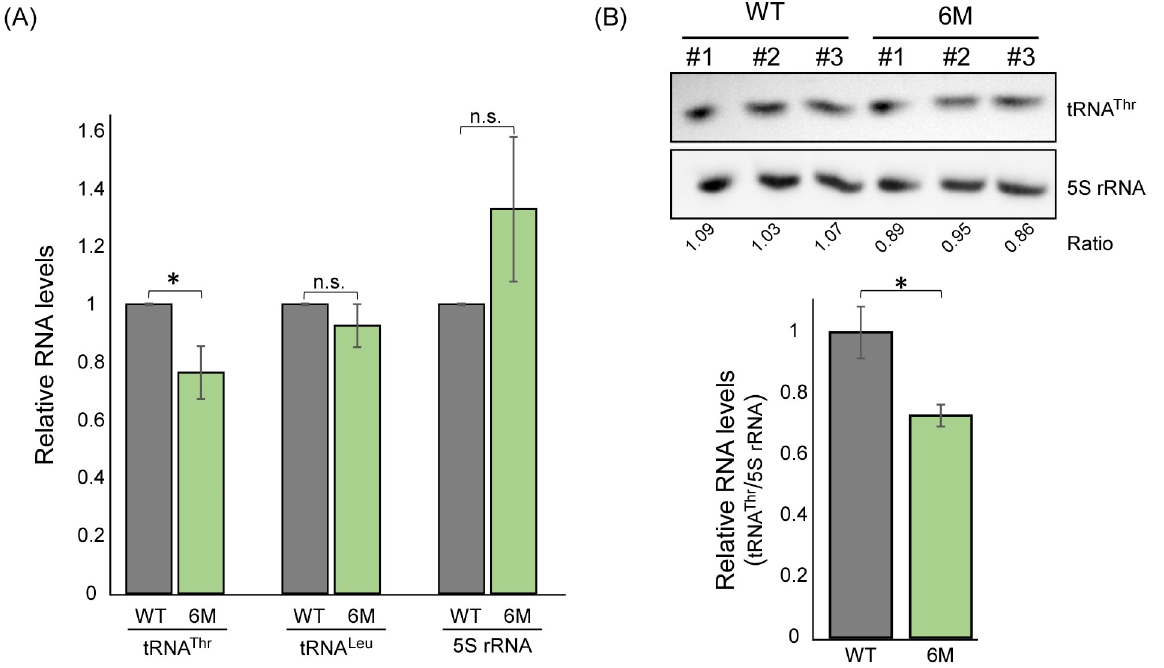
Figure 5. RPC10 impact on tRNA Thr expression. ( A ) Amounts of tRNA Thr(AGU) , tRNA Leu(CAA), and 5S rRNA were quantified in the indicated strains by RT-qPCR analysis and normalized to ACT1 expression levels. The histogram presents the quantification of five independent biological repeats. ( B ) RNA samples (2.5 µ g) from the indicated strains (three biological replicates each) were resolved on 10% acrylamide/8 M Urea gel and subjected to northern analysis with Biotin-labeled probes followed by detection with HRP-conjugated streptavidin and an ECL reaction. ’Ratio’ is the quantification ratio between the tRNA and 5S signals in each lane. Histogram presents the 5S-normalized tRNA Thr quantification. p ‐ value was calculated by the dependent samples’ one ‐ tailed t ‐ test. * <0.05 .